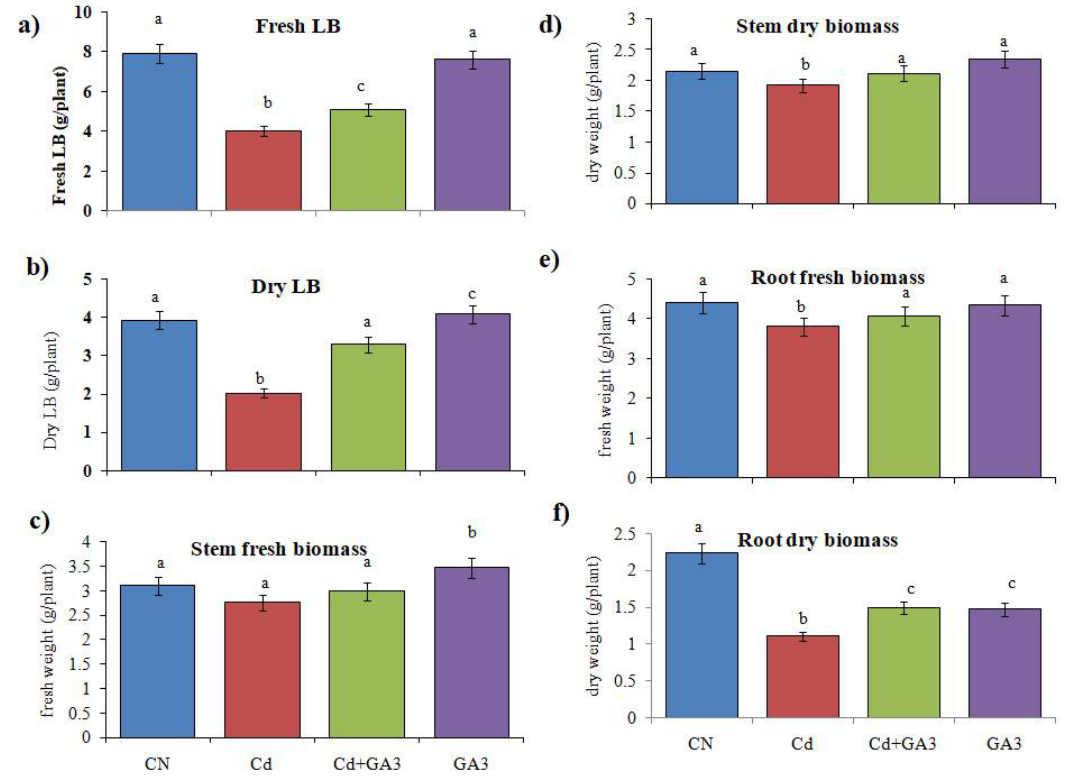
Figure 3. Effect of GA 3 on the biomass of mung bean plants under cadmium (Cd) stress in soil.Effect of GA 3 with or without cadmium (Cd) stress on fresh leaf biomass ( a ), dry leaf biomass ( b ), stem fresh biomass ( c ), stem dry biomass ( d ), root fresh biomass ( e ) and root dry biomass ( f ) of mung bean plants grown in soil in pots at time of harvest. Control (CN), cadmium (Cd) stress, Cd+ gibberellins (GA 3 ), and GA 3 alone conditions. Data presented are means ± standard errors ( n = 10, biological replicates). Different letters (a, b, c) indicate significant differences from control in all combinations (Tukey’s test, p ≤ 0.05).